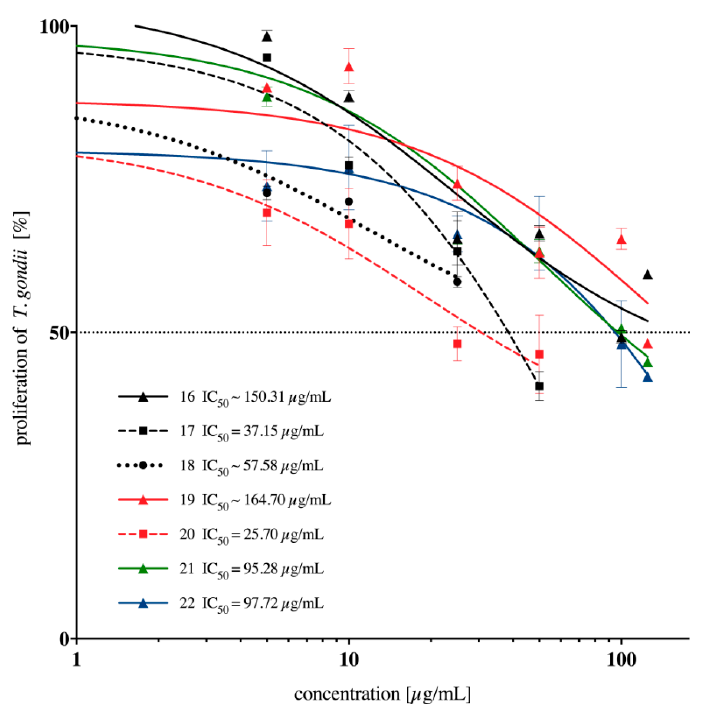
Figure 4. Dose response curves and IC 50 values [ µ g/mL] of compounds 16 – 22 on T. gondii proliferation.